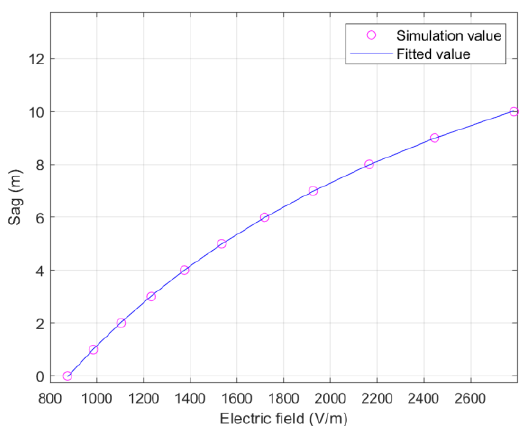
Figure 5. Relationship between sag and electric